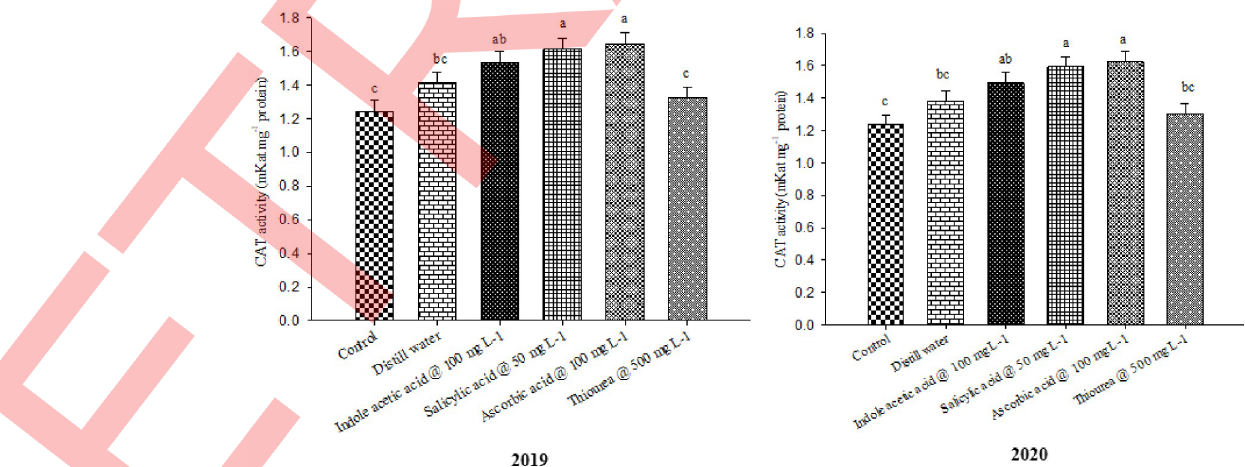
Fig 4. The influence of seed priming with different growth regulators on CAT contents of Indian squash. The error bars represent ± standard error of the means. Alphabets on bar showed a significant difference ( P � 0.05) among seed priming